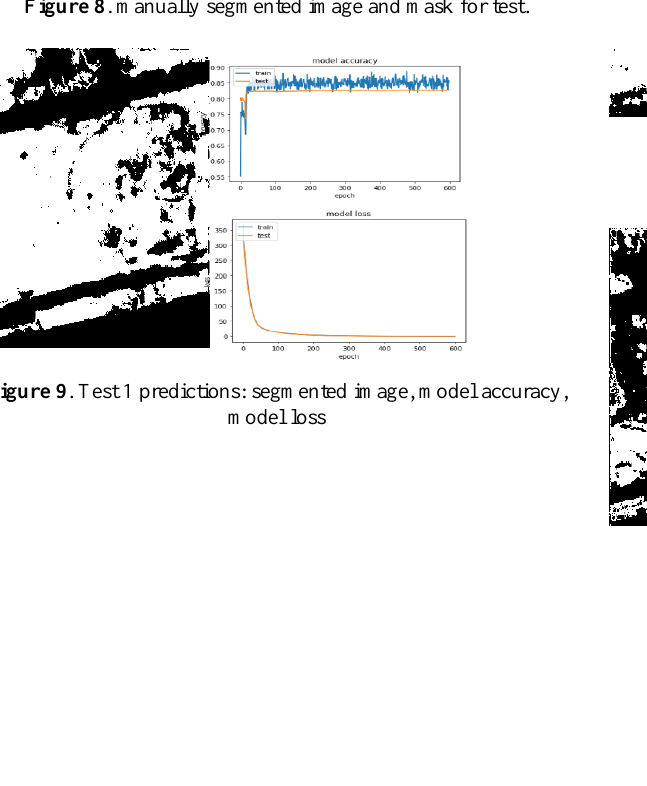
Figure 8 . manually segmented image and mask for test.